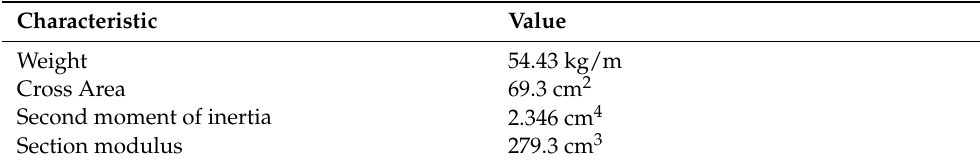
Table 2. Rail UIC 54: Mechanical